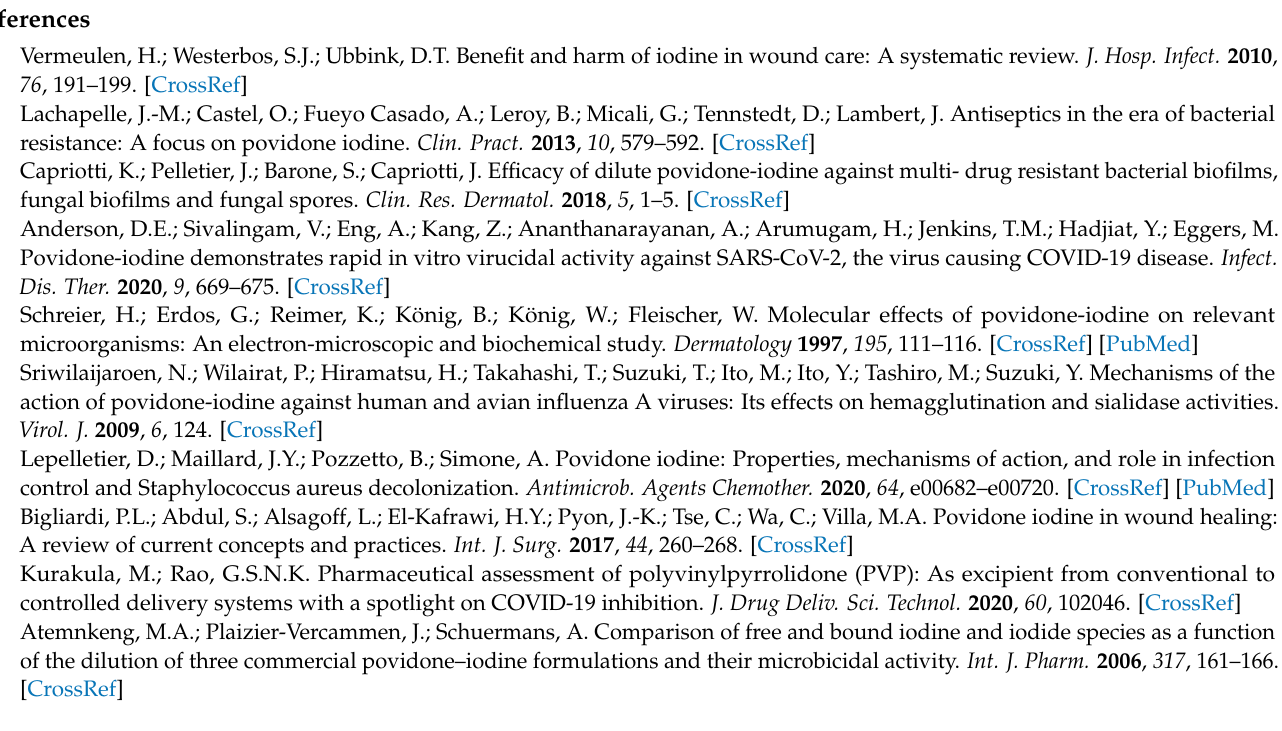
Table S2. Accelerated stability test on solid iodine–cyclodextrin complexes; Figure S6. XPS survey spectrum of HP- β -CD and HP- β -CD/I2 (SH sample) solids; Figure S7. Variation of iodine content of iodine–cyclodextrin complexes on storage at 25 ◦ C in polyethylene bag; Table S3. Variation of iodine content of iodine–cyclodextrin complexes in solution; Table S4. % Inhibition of S. epidermis cell